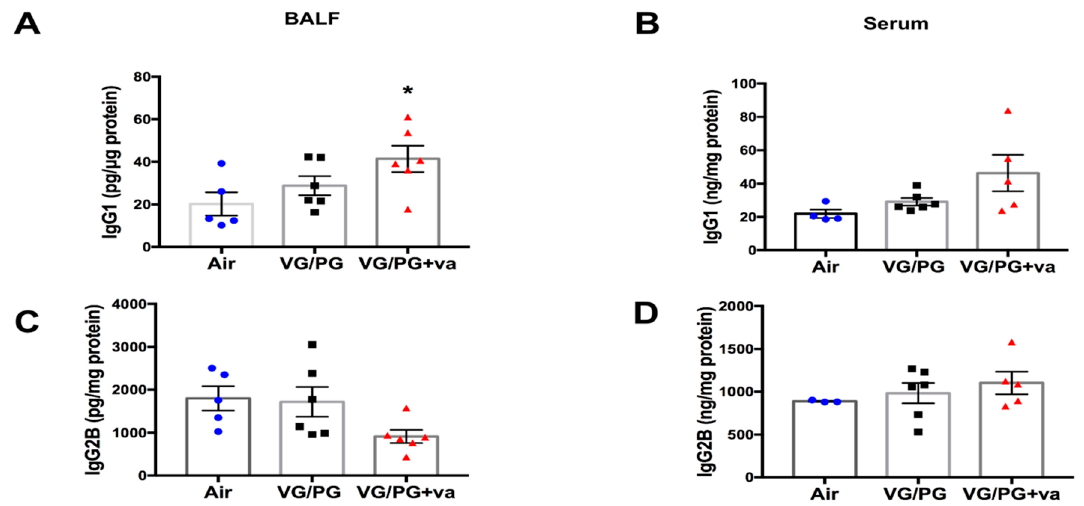
Figure 6. Inhalation of e-cig aerosols composed of 70%/30%VG/PG plus vanilla flavor alters IgG1 levels in bronchoalveolar lavage fluid (BALF). IgG1 and IgG2b levels measured by ELISA ( A , C ) in serum and BALF ( B , D ) ( n = 6 in all groups except the air control where n = 5). Values are normalized on protein. * p < 0.05. Error bars are SEM, and differences were analyzed by one-way ANOVA.